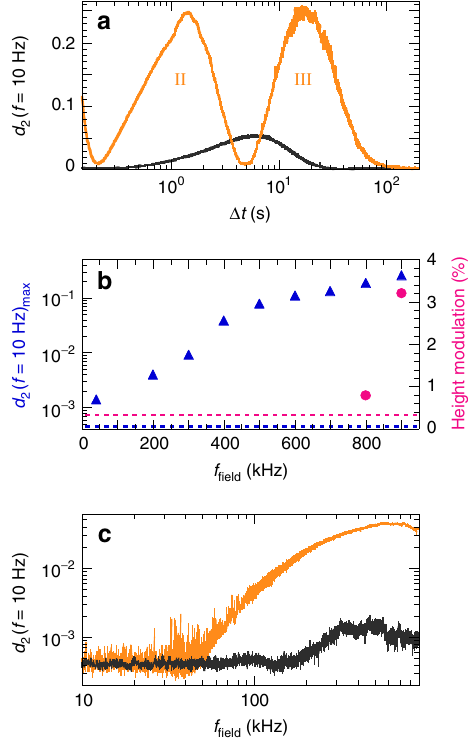
Fig. 6 Stages II – III: Network plasticization and deformation. a In a homeotropic LCN (orange line), the emergence of concerted mesogen dynamics (stage II) leads to ef fi cient surface motility (stage III), whereas an isotropic network (dark grey line) lacks the fi nal deformation stage. b Peak motility in stage III (blue triangles, left ordinate) and % height change measured by DHM (magenta bullets, right ordinate) versus fi eld frequency. Both techniques show an increase in surface expansion with increasing f fi eld , yet the relatively lower noise level of LSI compared to DHM (dashed lines) allows probing over an order-of-magnitude lower fi eld frequencies (down to ~40 kHz versus ~800 kHz). c Field frequency sweep from 0 to 900kHz at 0.9 kHz s − 1 for a homeotropic network (orange line) and isotropic network (dark grey line), con fi rming the extraordinarily high